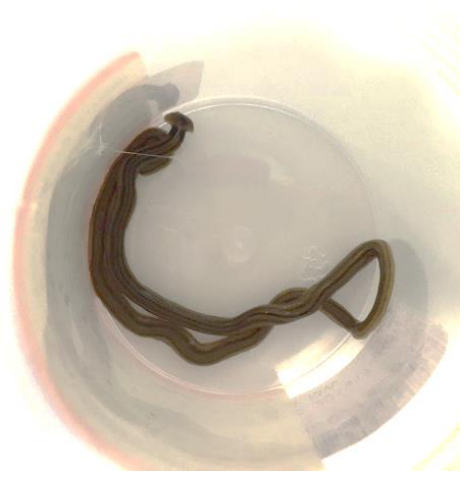
Figure 6. Worm thought to have wriggled out of feces on the floor in an incontinent patient. e-Diagnosis members